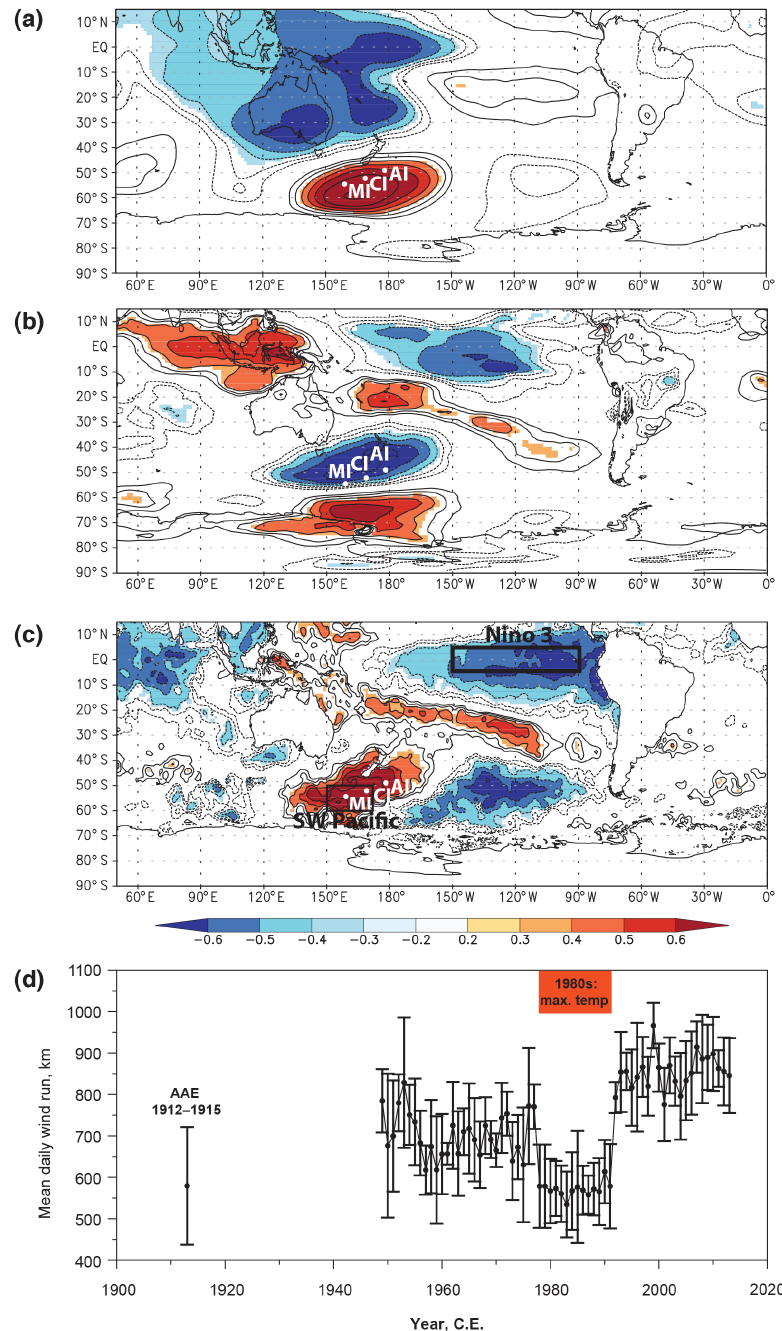
Figure 5. Climate controls on temperature over Macquarie Island. Spatial correlations between detrended and deseasonalised Macquarie Island mean monthly atmospheric temperatures (October–March) and 850hPa height (a) , zonal wind stress using ERA-Interim 31 (b) and sea surface temperature (HadISST; c ) (Rayner et al., 2003) for the period 1979–2013 ( p field < 0 . 05). Note: Campbell Island (CI) and the Antipodes Islands (AI) fall within the region of greatest correlation to SSTs in the southwest Pacific. The southwest Pacific (SW Pacific; 50–60 ◦ S, 150–170 ◦ E) and Nino 3 regions also shown. For comparison, mean seasonal (October–March) daily wind run (kilometres) for the meteorological station at Macquarie Island (source: Bureau of Meteorology) with comparison to average from the Australasian Antarctic Expedition (1912–1915) with 1 σ uncertainty (d) . Note, the period of decreased wind speed across the 1980s coincides with maximum air temperatures over Macquarie Island (see Fig.